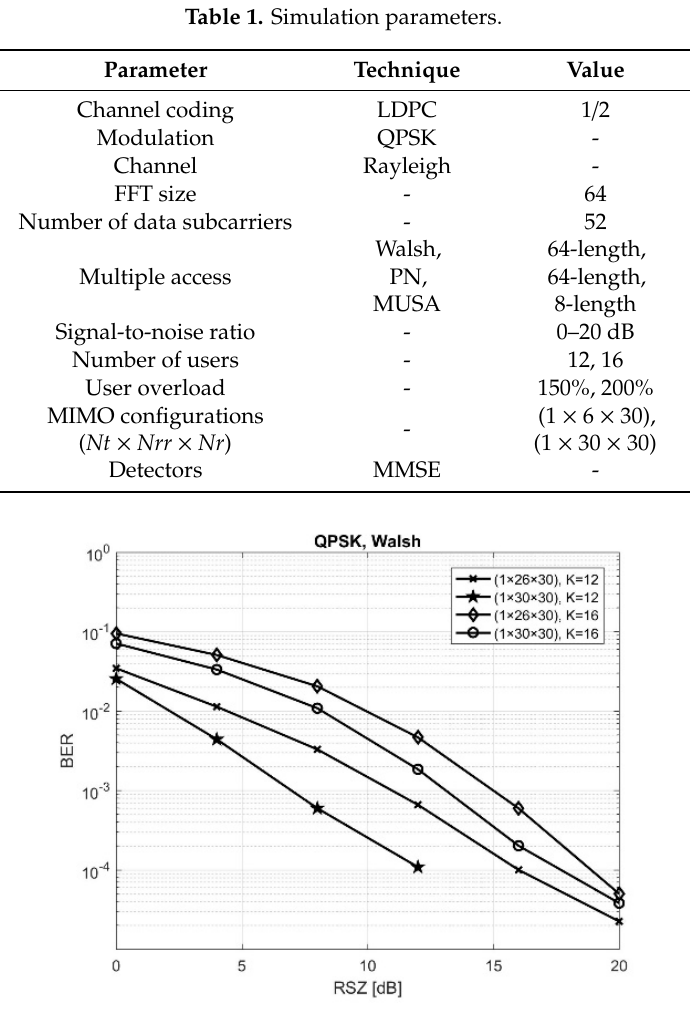
Figure 3. BER vs. SNR for (1 × 26 × 30) and (1 × 30 × 30) MIMO configurations, QPSK modulation, Walsh codes with 12, 16 active users.